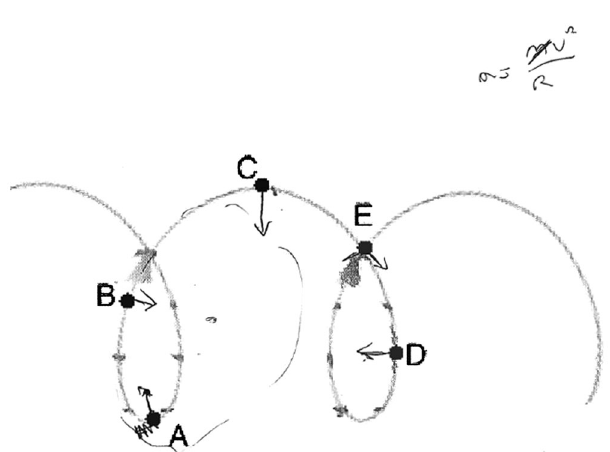
FIG. 3. Felix ’ s written work on the cycloid problem during the second